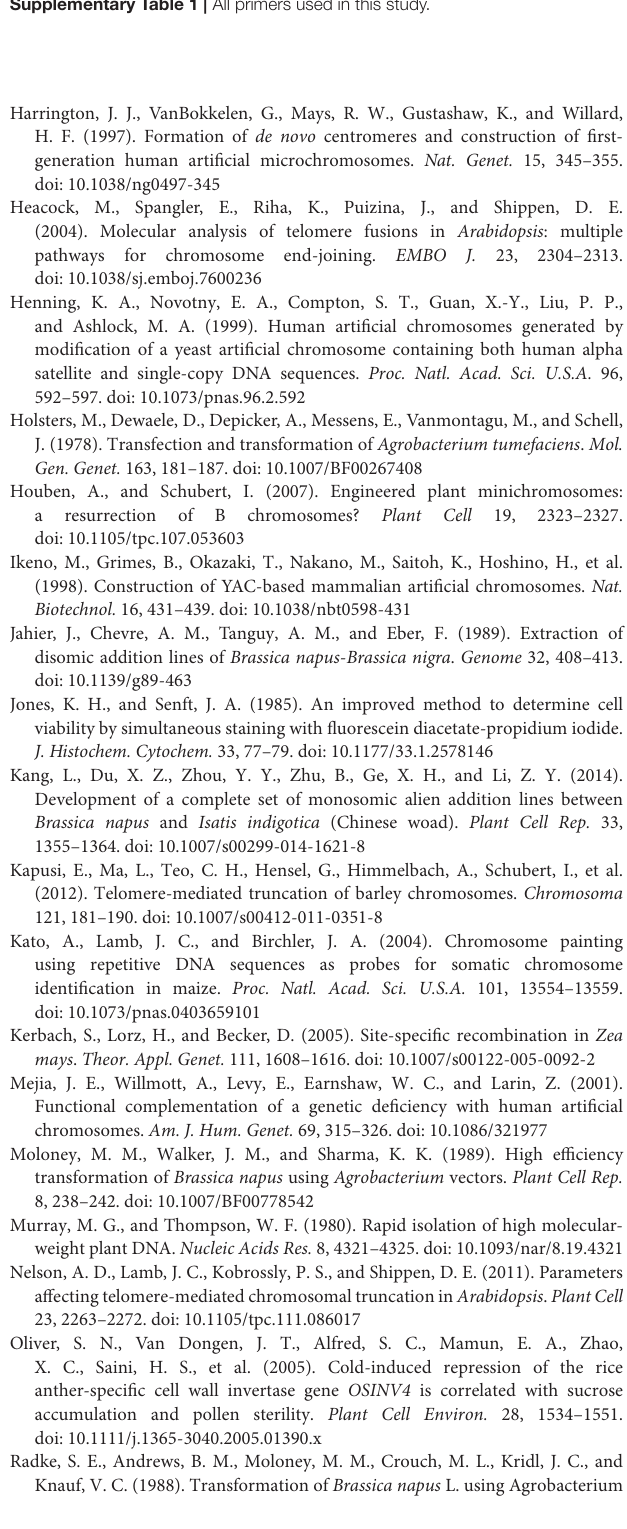
Supplementary Table 1 | All primers used in this